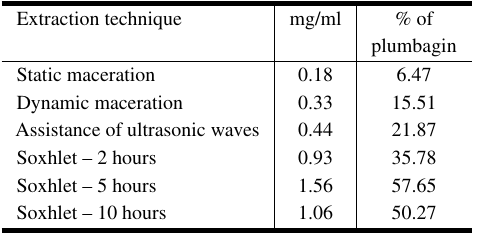
Plumbagin content (mg/ml) and its percent- age in roots of Plumbago scandens according to different extraction